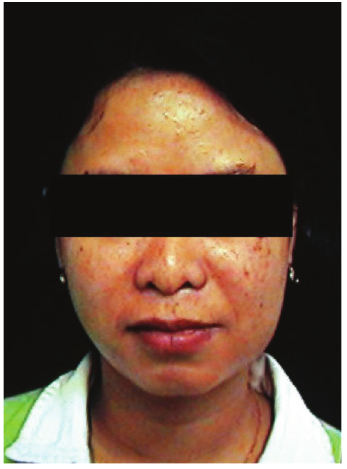
Figure 1: Unilateral left parotid mass.